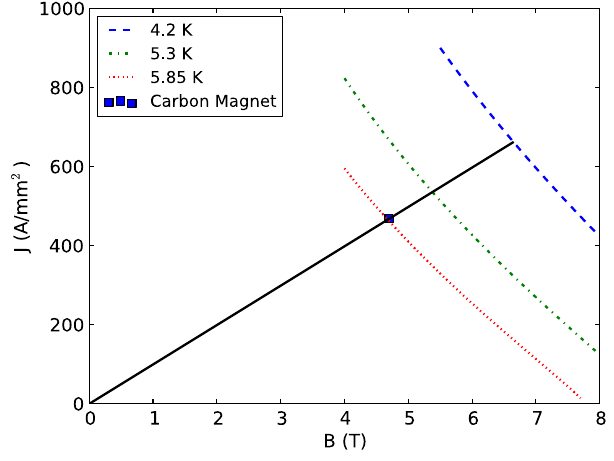
FIG. 21. Load line of the carbon F/D